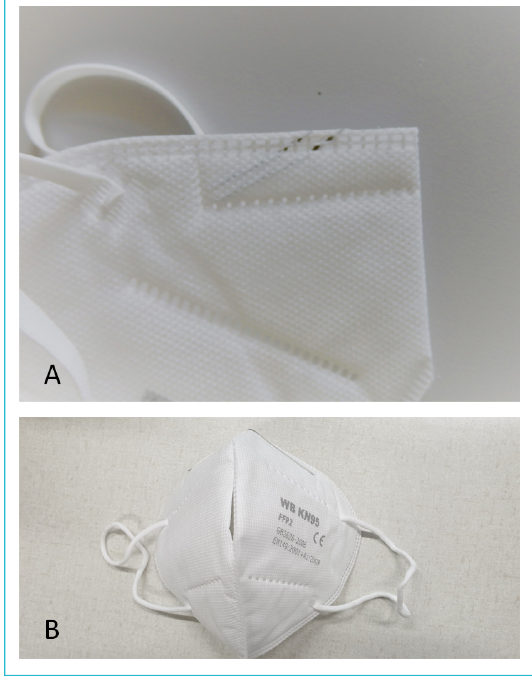
Figure 5: Example (a, above) nose piece wrongly mounted; exam- ple (b, below) the two halves of the FFP respirator are not properly sealed together.